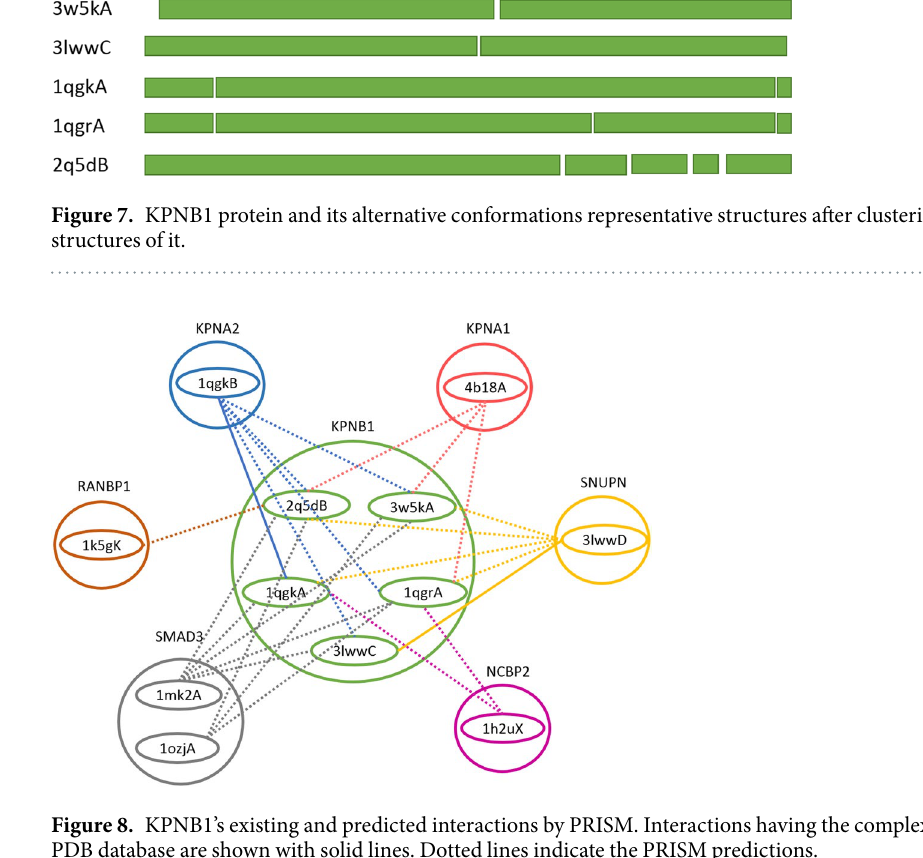
different cluster representatives based on our algorithm. As can be clearly seen from the figure, PDB structures 1ibrB and 2qnaA cover different parts of KPNB1 so we don’t use them as alternative conformations of KPNB1 in our analysis. 3D structures of the five alternative conformations of KPNB1, i.e. 3w5kA, 3lwwC, 1qgkA, 1qgrA, and 2q5dB, are shown in Supplementary Fig. S3 and the RMSD values of their aligned structures are shown in Supplementary Table S3. These structures show the open and close conformations of KPNB1. We submitted all possible interactions of KPNB1 with its neighbours using their alternative conformations to PRISM. For representation purposes we focus only on 6 different interactions of KPNB1 in our network. Based on the PRISM predictions, we reach the structural network shown in Fig. 8. The complex structures of interactions KPNB1-SNUPN and KPNB1-KPNA2 are already available in the PDB database namely PDB ids 3lww and 1qgk, respectively. The close conformation of KPNB1 i.e. 3lwwC is bound to SNUPN (Snurportin-1). KPNB1 uses SNUPN adapter to bind cargo molecules to import m 3 G-capped U snRNPs 57 . SNUPN has an IBB (importin- β -binding) domain in its N-terminal which is used to bind to KPNB1 and then transport to the nucleus. It has been shown that after each round of import, SNUPN uses CRM1 to return back to the cytoplasm 58 . KPNB1 close conformation 3lwwC bound to SNUPN is represented in Fig. 9a. This complex protein structure has the global binding energy of − 49.82 based on the Fiberdock webserver 53, 54 . To detect the binding residues in this complex structure we used HotRegion webserver 59 . The binding residues of this complex structure are listed in Supplementary Table S4, and they are indicated with opaque colours in the figure. We used UCSF Chimera package 60 for molecular graphics and analyses. Notwithstanding the high RMSD values between open and close conformations of KPNB1, Bhardwaj and Cingolani 61 provided structural evidence that open and close conformations of KPNB1 bind to SNUPN IBB domain. We had the same results in PRISM predictions as shown in Fig. 8. It should be noted that, though SNUPN binds to all conformers of KPNB1, it has a different affinity, in terms of binding energy, towards each conformer. For example, the predicted binding energy scores for the interaction of SNUPN with 2q5dB and 1qgkA conformers are − 67.38 and − 53.32 respectively.